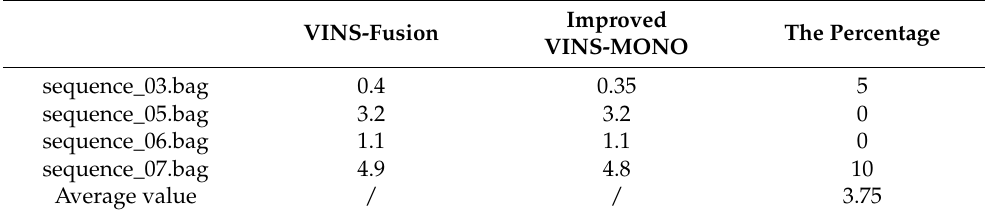
Table 19. The absolute pose error of VINS-Fusion algorithm is compared with that of the improved algorithm in the underwater dataset (Unit: